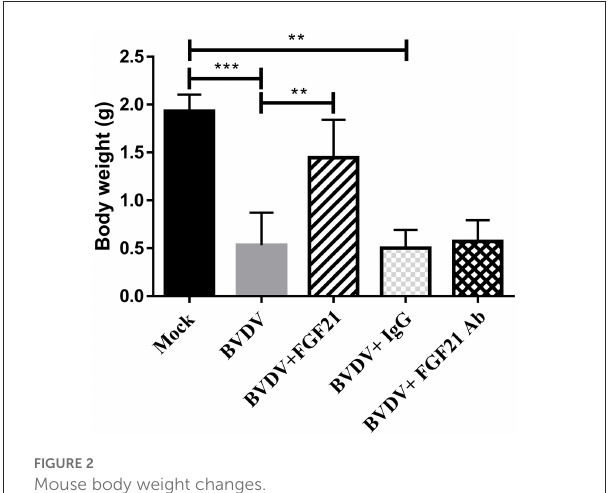
FIGURE2 Mouse body weight changes.